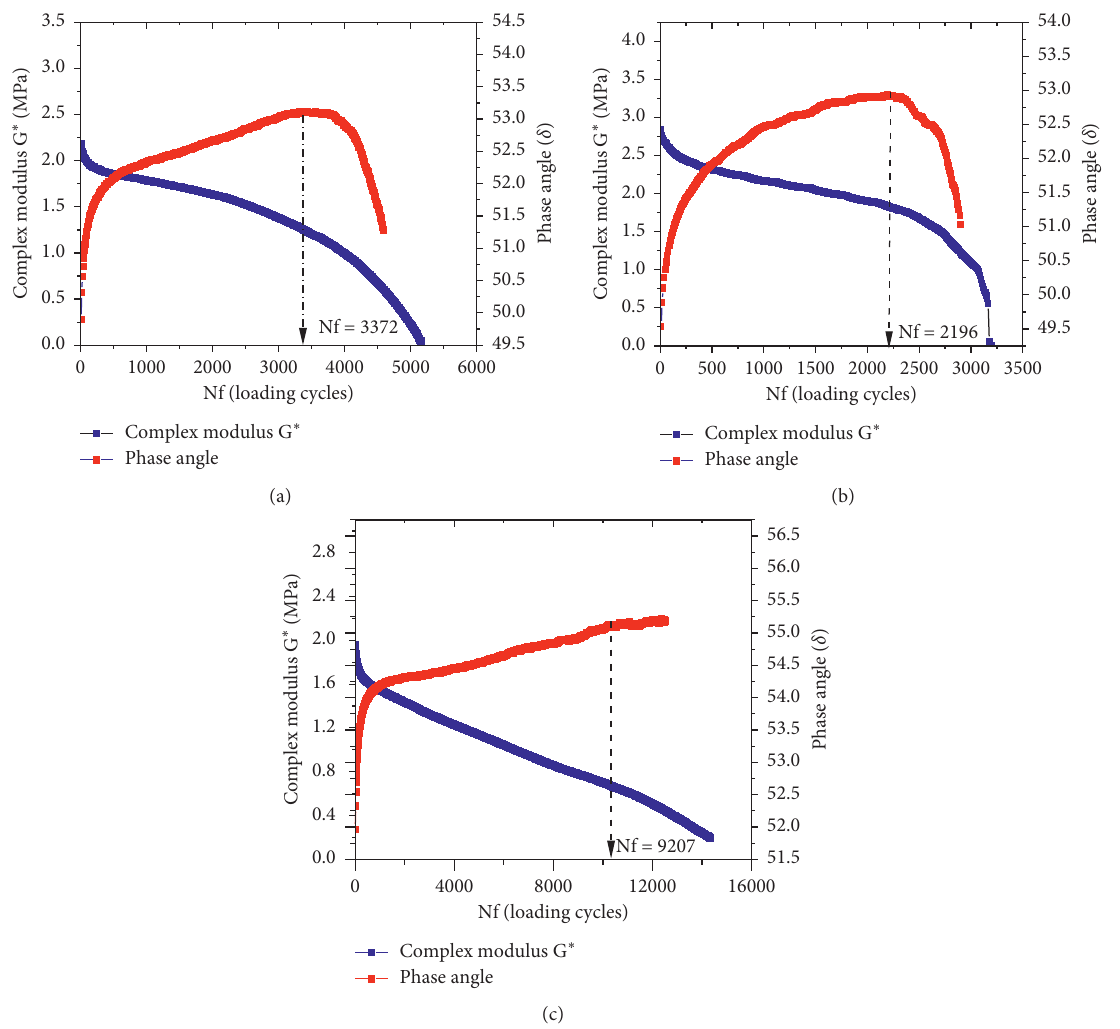
Figure 10: Complex modulus and phase angle results rubberized binders from time sweep test. (a) Control. (b) Tego XP. (c) Tego